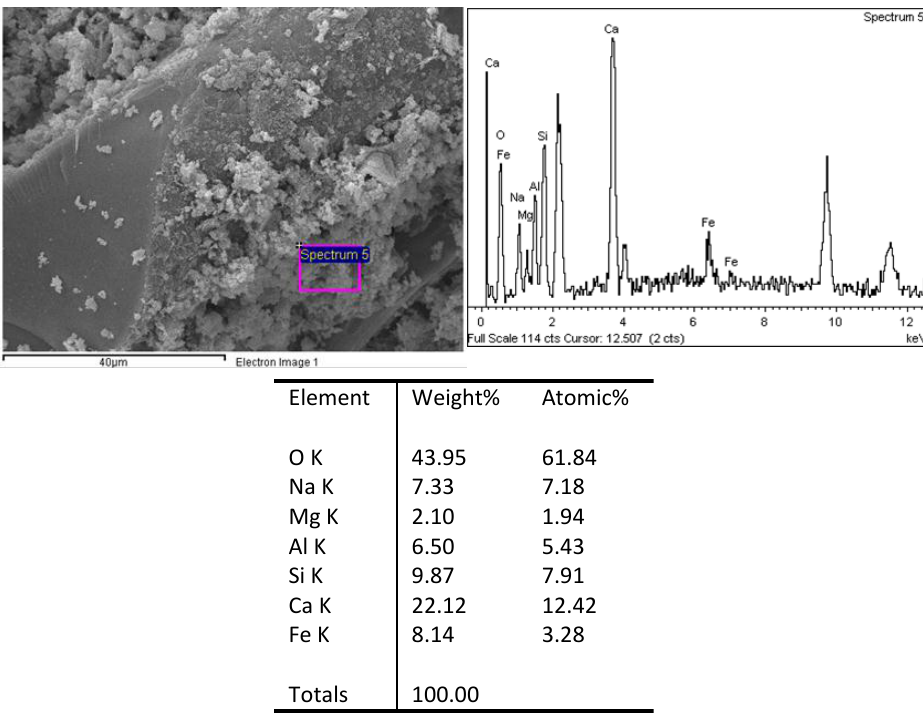
Figure 17. EDS spectrum alkali-activated hybrid cement